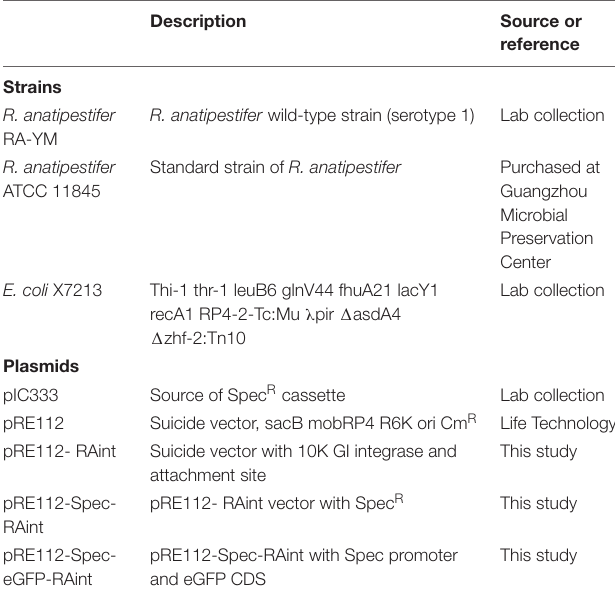
TABLE 1 | Bacterial strains and plasmids used in this